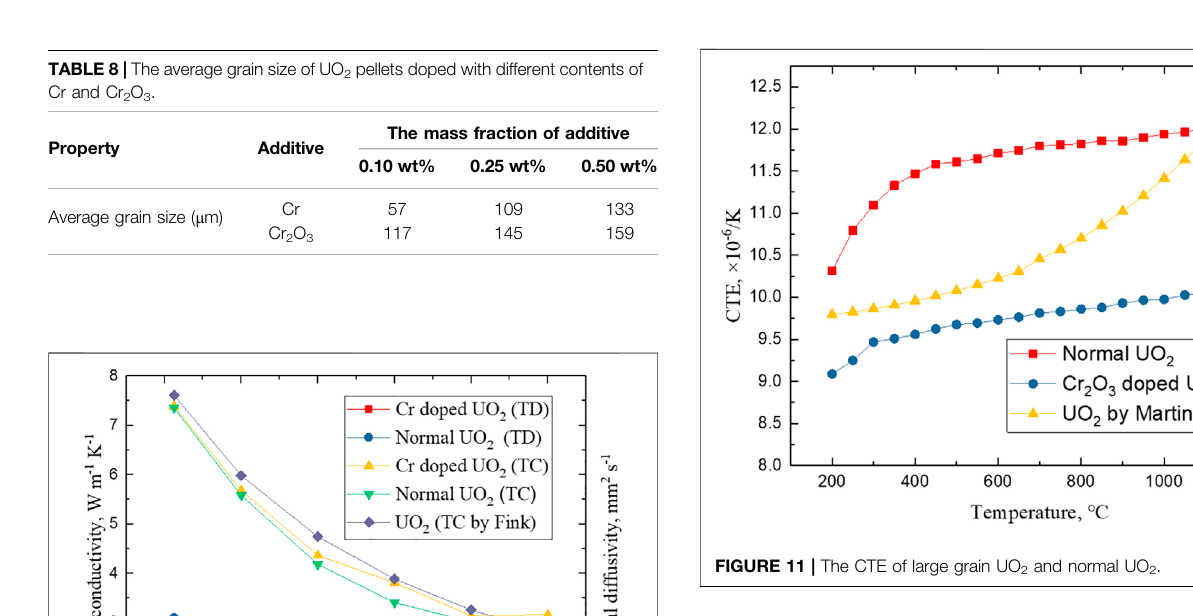
Figure 9 . The CTE of large grain UO